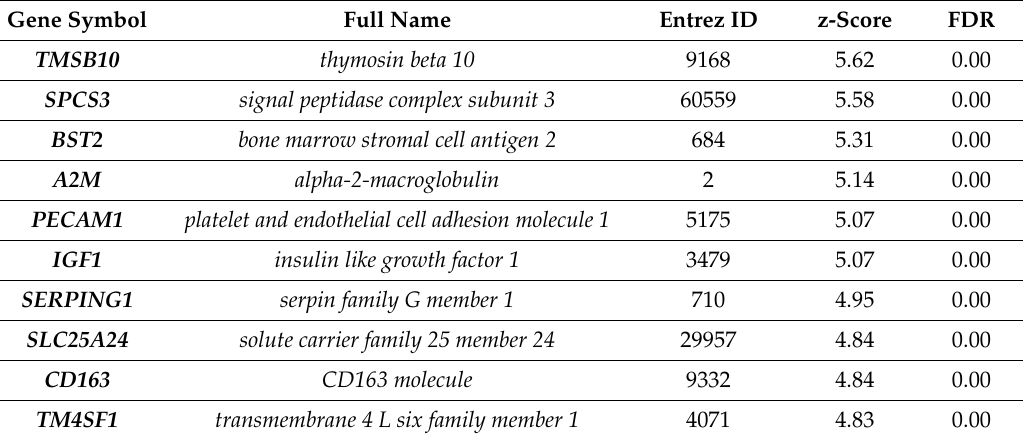
Table 2. Top 10 up-regulated di ff erentially expressed genes (DEGs) between the merged-disease group and the control